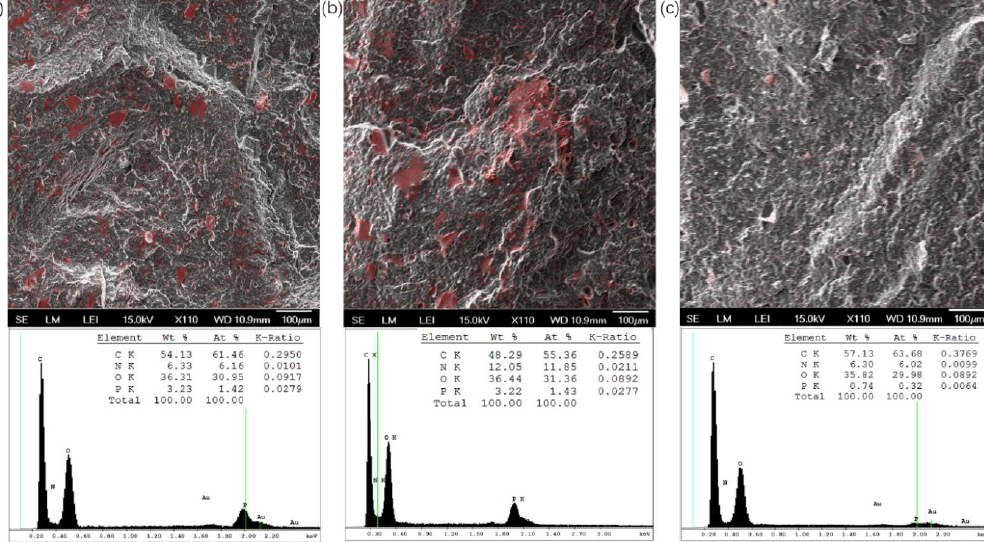
Figure 7. SEM-EDS mapping (top) and element analysis spectra (bottom) of cross-section surface from a 10% UP-loaded PHS tablet ( a ) before release, ( b ) at 72 h, and ( c ) at 588 h in water of 25 °C (red represents locations with phosphorous present). EDS: energy-dispersive spectroscopy.